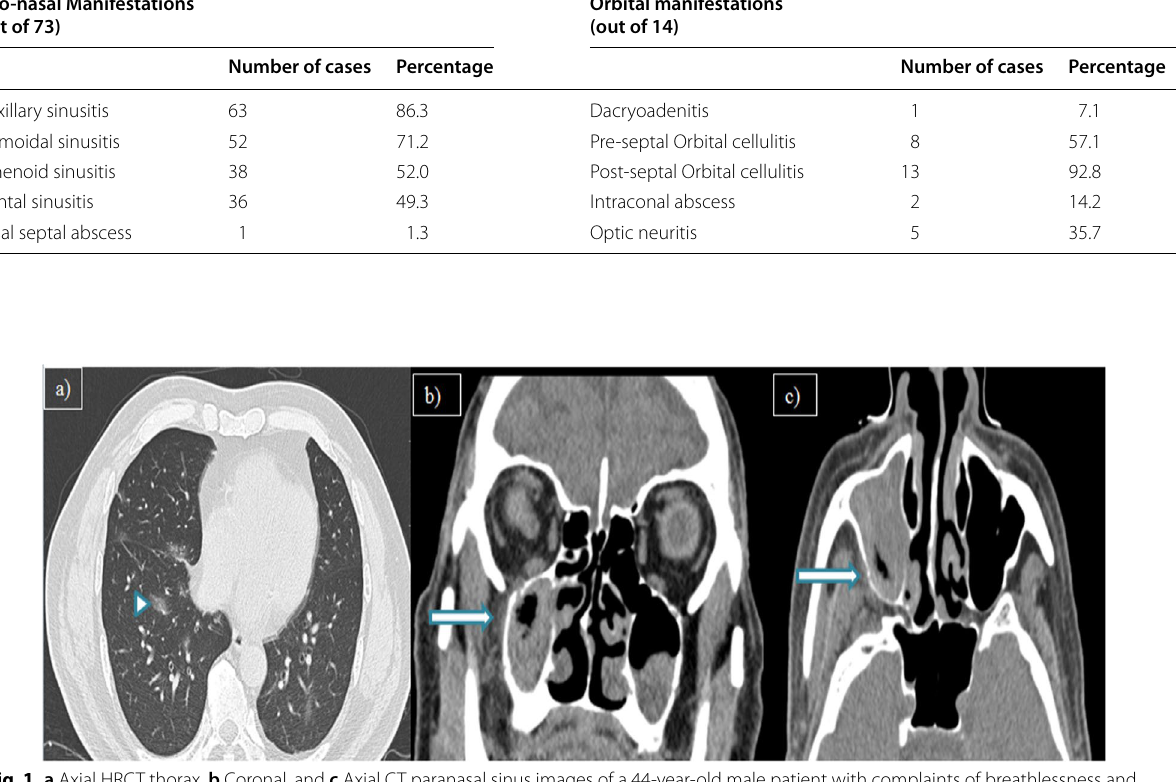
Fig. 1 a Axial HRCT thorax, b Coronal, and c Axial CT paranasal sinus images of a 44-year-old male patient with complaints of breathlessness and rhinorrhea showing patchy ground glass opacities in right lower lobe (arrowhead) and bilateral maxillary sinusitis with periantral space fat stranding